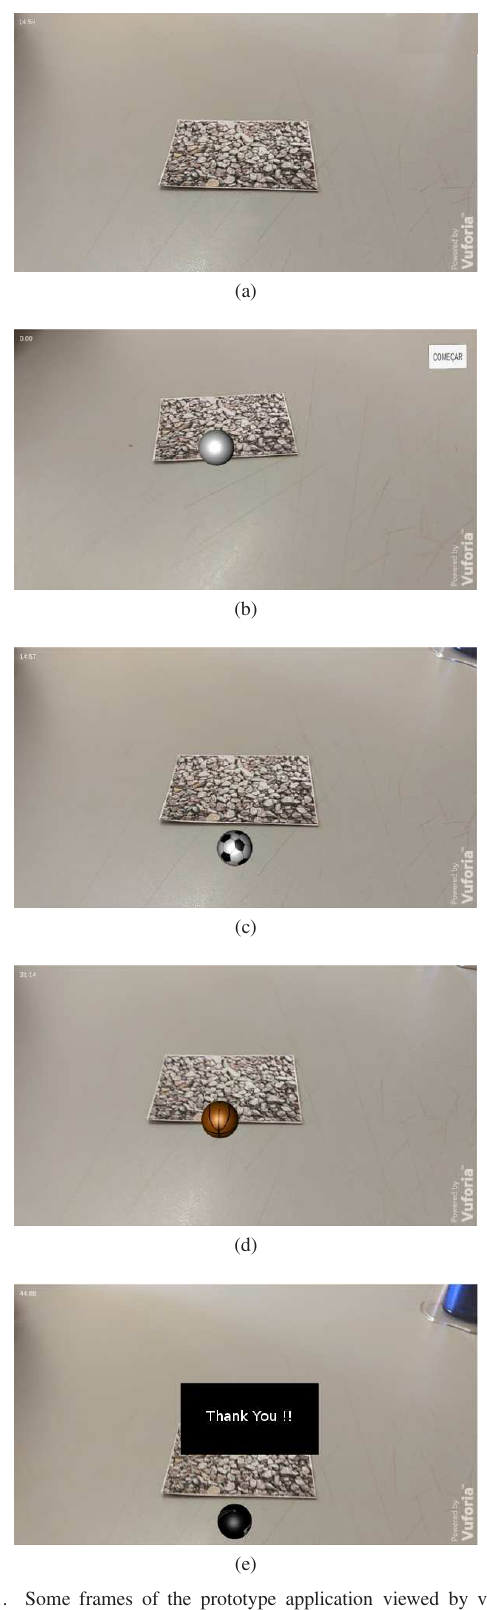
Figure 4. Times spent by volunteers using 5.5, 7 and 10.1